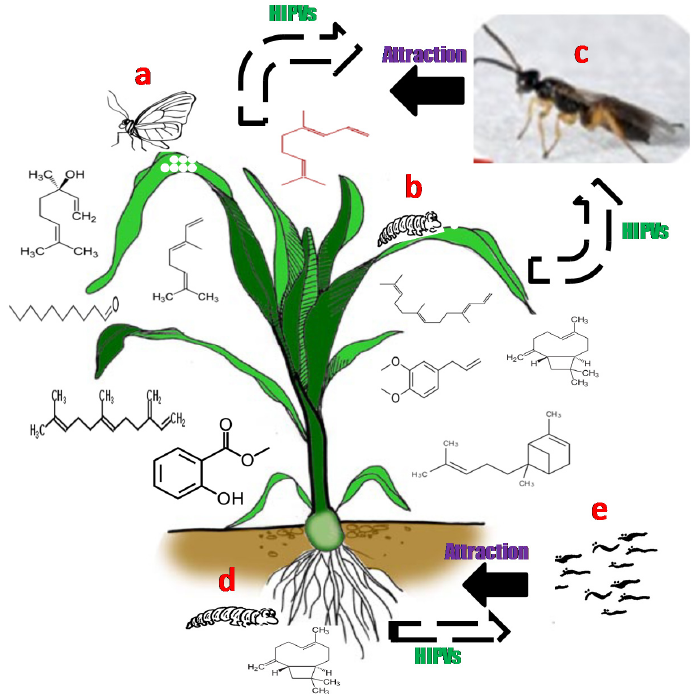
Figure 1. Aboveground and belowground herbivore ‐ induced plant volatiles (HIPVs) emitted by maize plant in response to spotted stemborer Chilo partellus oviposition ( a ) and feeding ( b ) and the corn rootworm ( Diabrotica virgifera virgifera ) feeding ( d ). The bioactive HIPVs produced in response to the herbivores infestation were attractive to natural enemies of the herbivores, i.e., the parasitic wasp Cotesia sesamia ( c ) and entomopathogenic nematode ( e ).